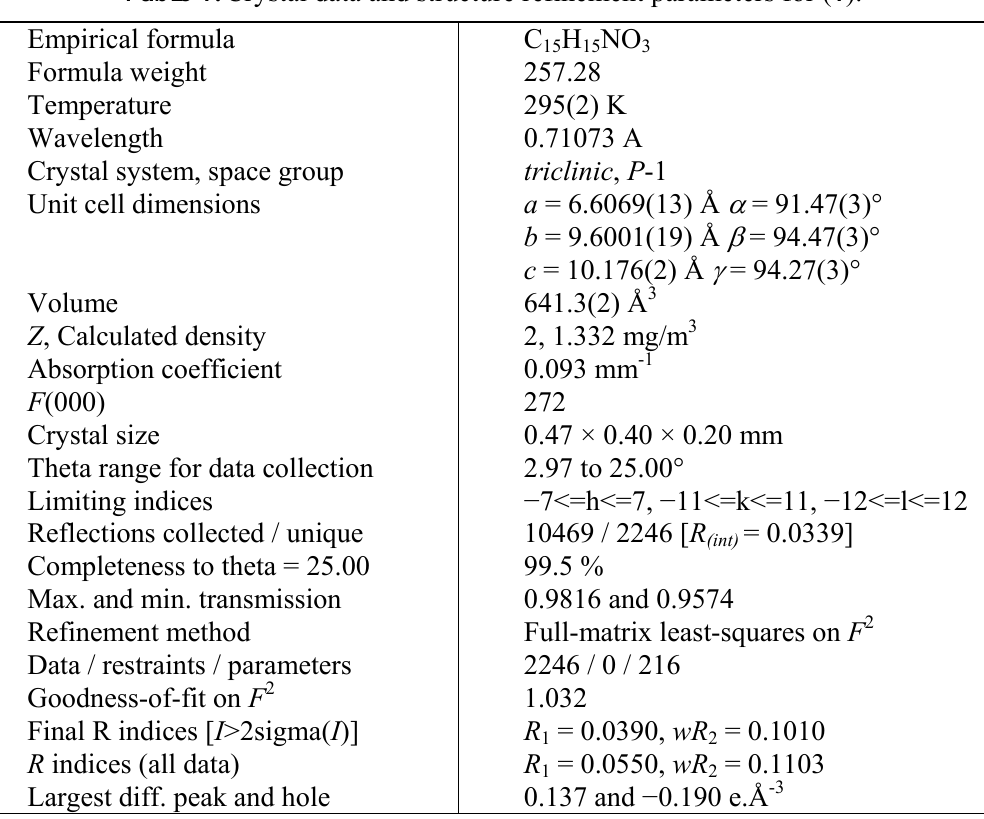
Table 4. Crystal data and structure refinement parameters for ( 1